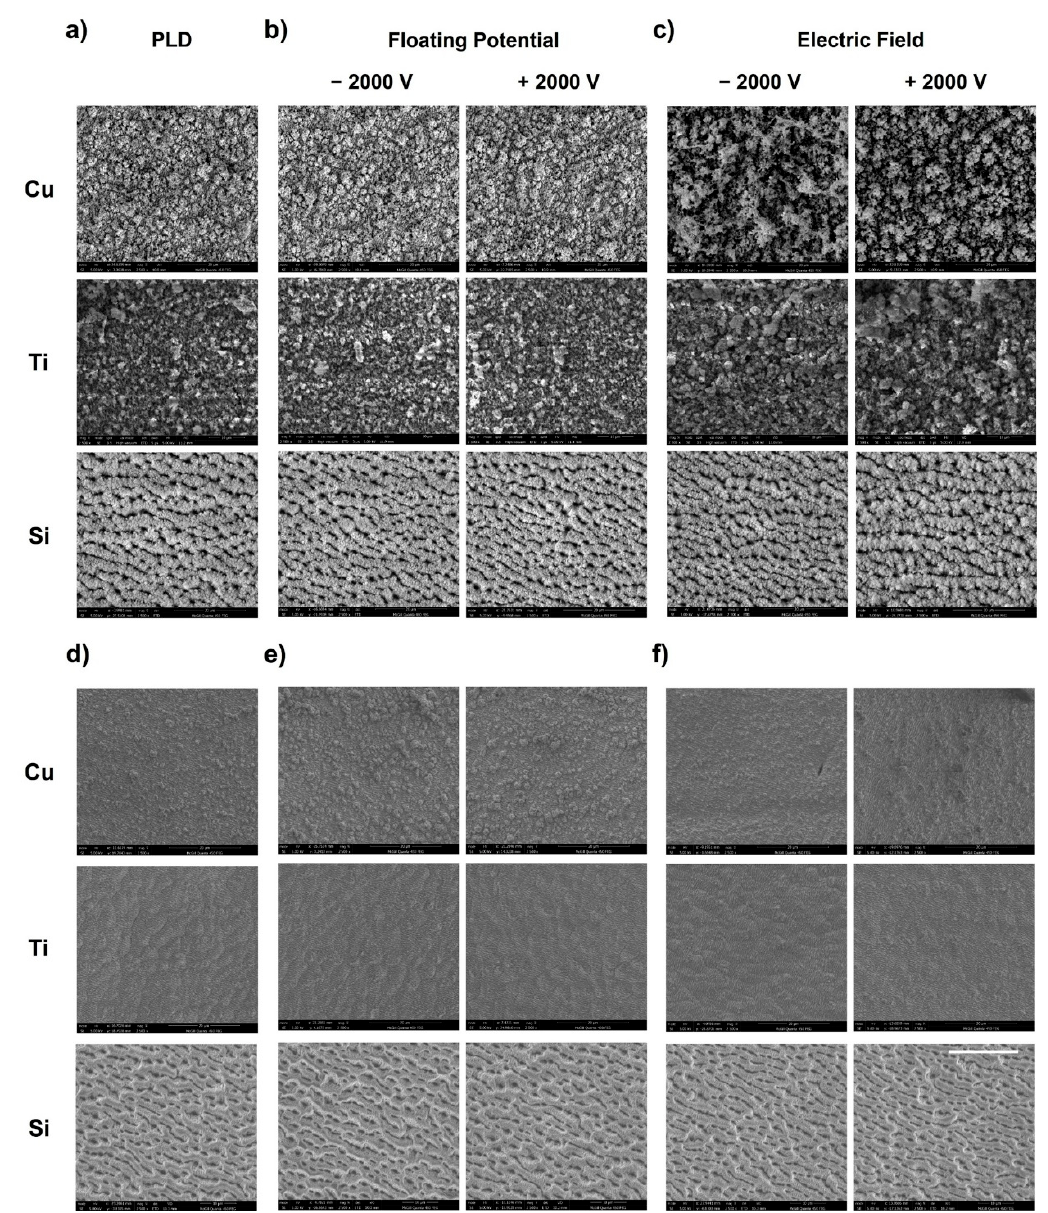
Figure 6. SEM images of Cu, Ti and Si surfaces laser micromachined in the parallel laser scanning direction under conventional PLD conditions ( a , d ), in the presence of a floating potential ( b , e ), and in the presence of an applied electric field ( c , f ), respectively, BEFORE and AFTER ultrasonication. The white scale bar corresponds to 20 µm and applies to all images.